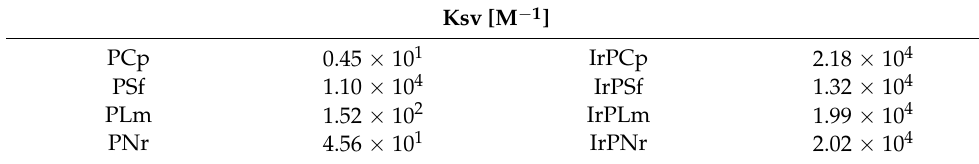
Figure 9. ( A ) Fluorescence quenching of apo-Tf (C = 3.6 × 10 − 6 M) by IrPCp (molar ratios 0.5, 1, 1.5, 2, 3, 4, 5, 6, 7, 8, 9, 10) in 50 mM pH 7.4 phosphate buffer; ( B ) Stern–Volmer plots of apo-Tf (C = 3.6 µ M) quenching by IrPCp , IrPNr , IrPSf , IrPLm , PCp , PNr , PSf , PLm (I 0 and I—intensity of HSA in the absence and presence of the increasing amounts of the compounds, respectively); ( C ) Circular dichroism spectra of apo-transferrin with Ir(III) complexes. Table 4. Determined Ksv values for the interactions of studied phosphine and Ir(III)